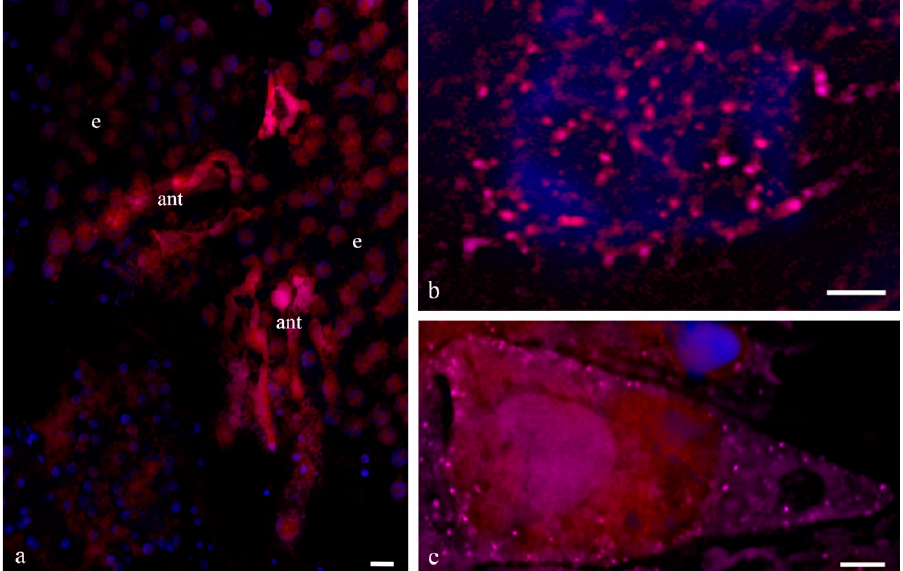
Figure 15. Localization of cytochrome c in the cytoplasm of the wheat antipodal complex cells during PCD. A complex of antipodal cells ( a ). Cytochrome c in the mitochondria of a functioning antipodal cell ( b ) and in the cytoplasm of the antipodal cell during PCD ( c ). ant—antipodal, e—endosperm. Scale 20 µm.